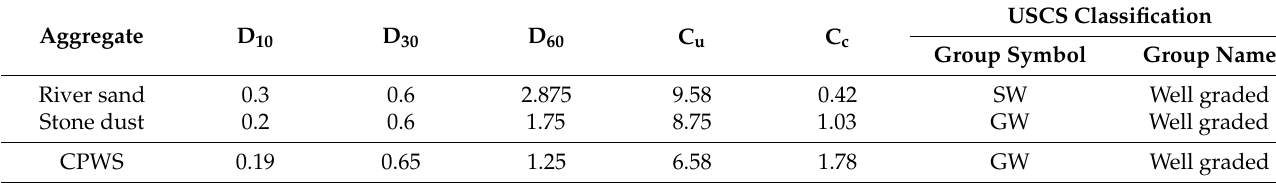
Figure 3. Particle size distribution for sand, stone dust and CPWS. Table 3. Particle size distribution of Table 4. Physical properties of constituent materials.